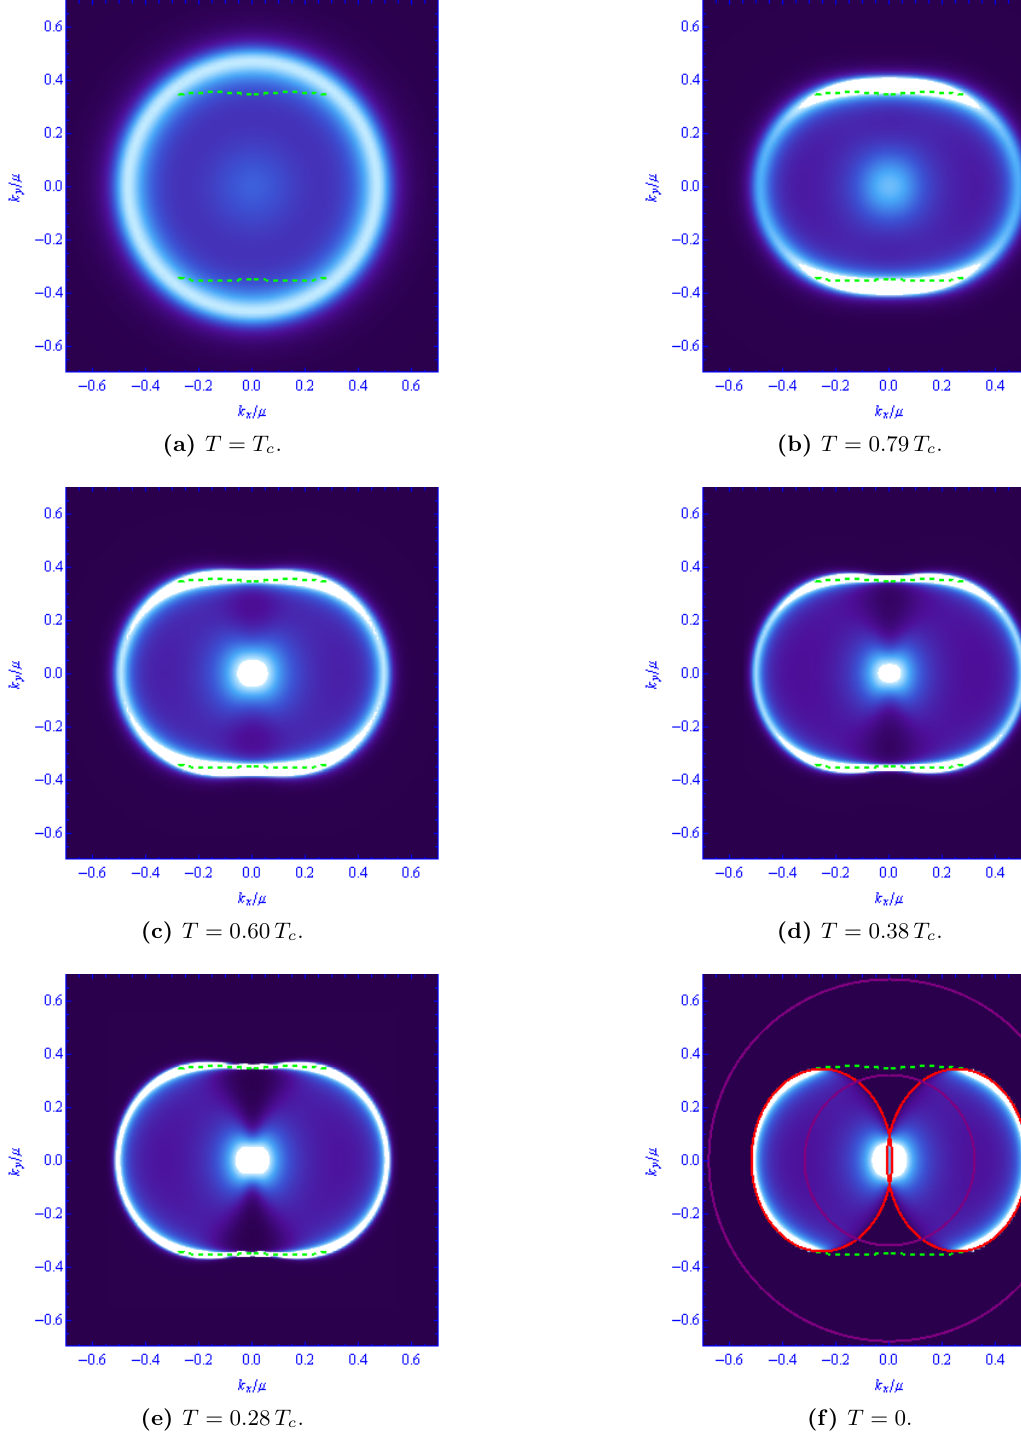
Figure 9. The spectral function for di(cid:11)erent temperatures and (cid:12)xed (cid:21) = 0 : 62 = (cid:21) c , ! = 0 : 18 (cid:22) . It is observed the presence of spherical symmetry at T = T c . The dashed lines indicates the locus of the normal modes. The purple and red circles represent the UV and IR Dirac cones respectively.